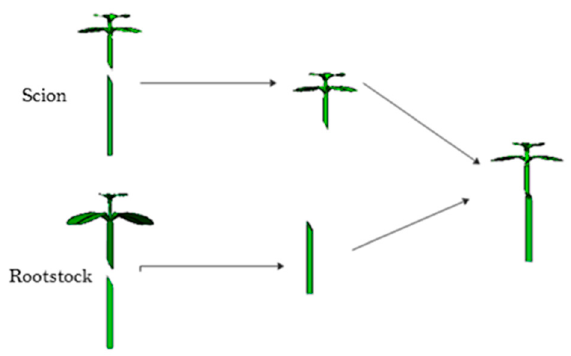
Figure 1. Stages of splice grafting.